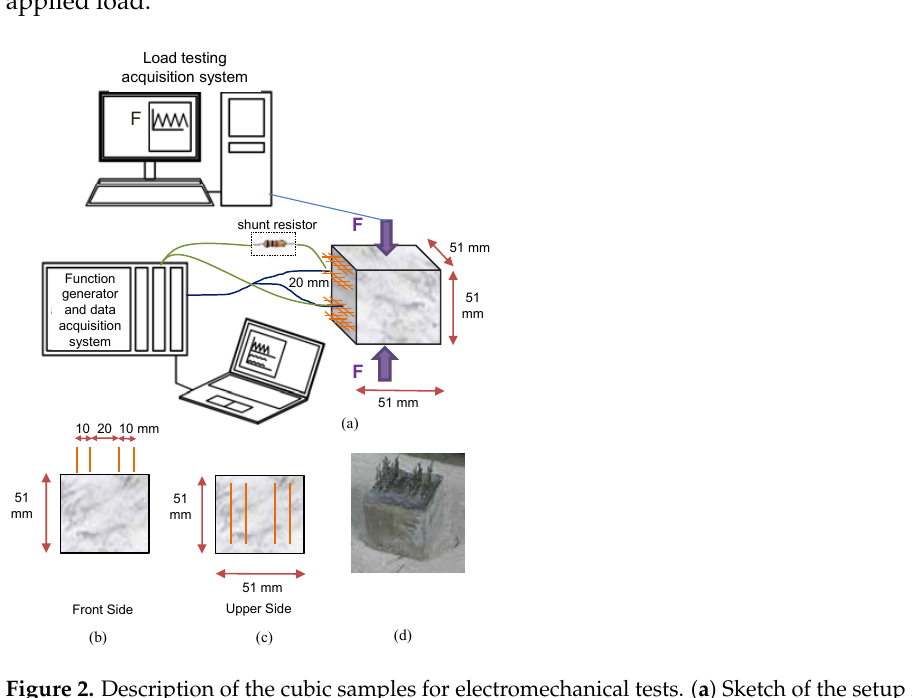
Figure 2. Description of the cubic samples for electromechanical tests. ( a ) Sketch of the setup for tests on cubes; ( b ) front side view; ( c ) upper side view; ( d ) photo of one cubic